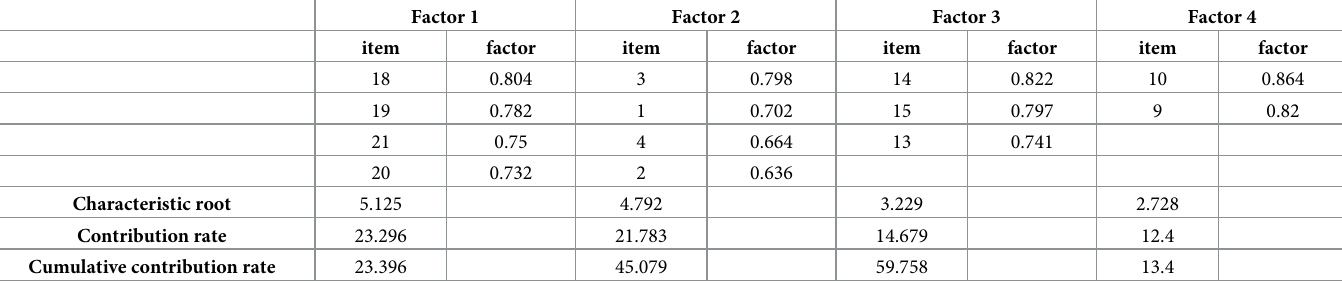
Table 1. Factor load value, eigenvalue and variance contribution rate of 15 items of the SNSU